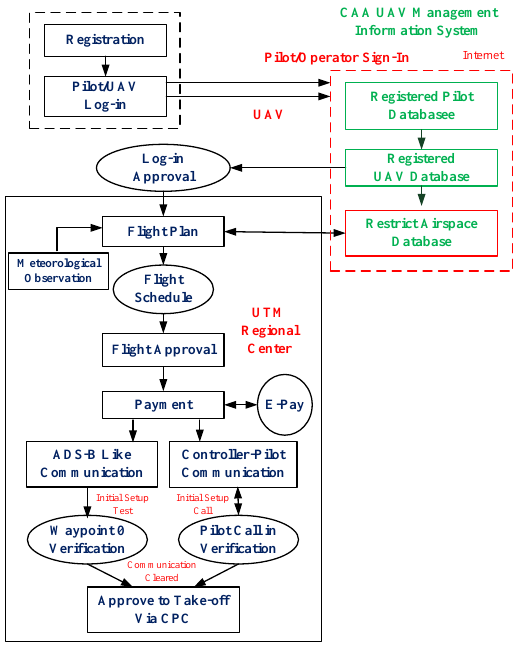
Figure 6. UTM pre-flight procedures.